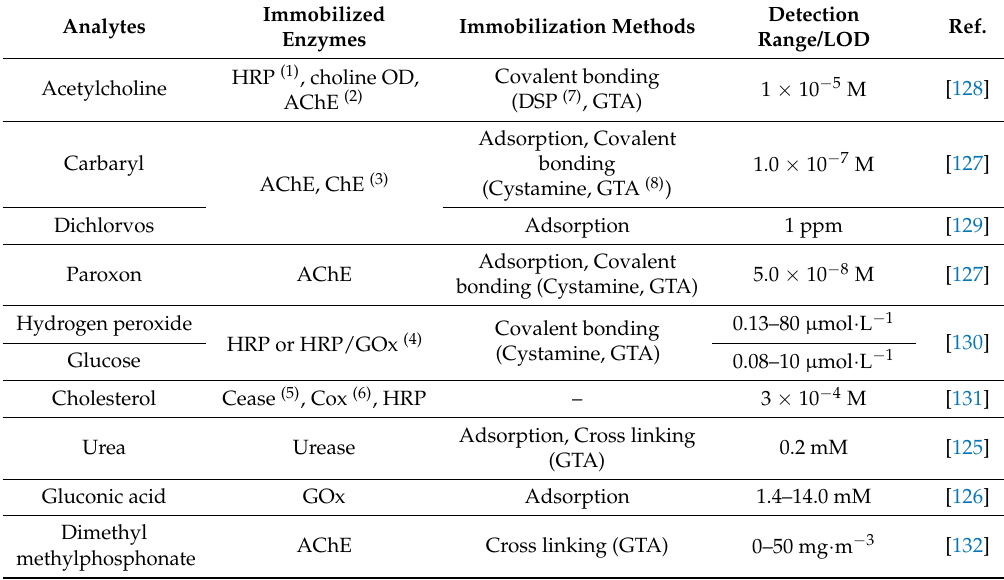
Figure 10. Schematic representation of the electrospun nanofibrous PLGA/Fullerene-C60-modified QCM for the real-time monitoring of gluconic acid. Adapted from [126]. Table 4. Summary of analytes, immobilized enzymes, immobilization methods and detection range/LOD of QCM enzyme biosensors.